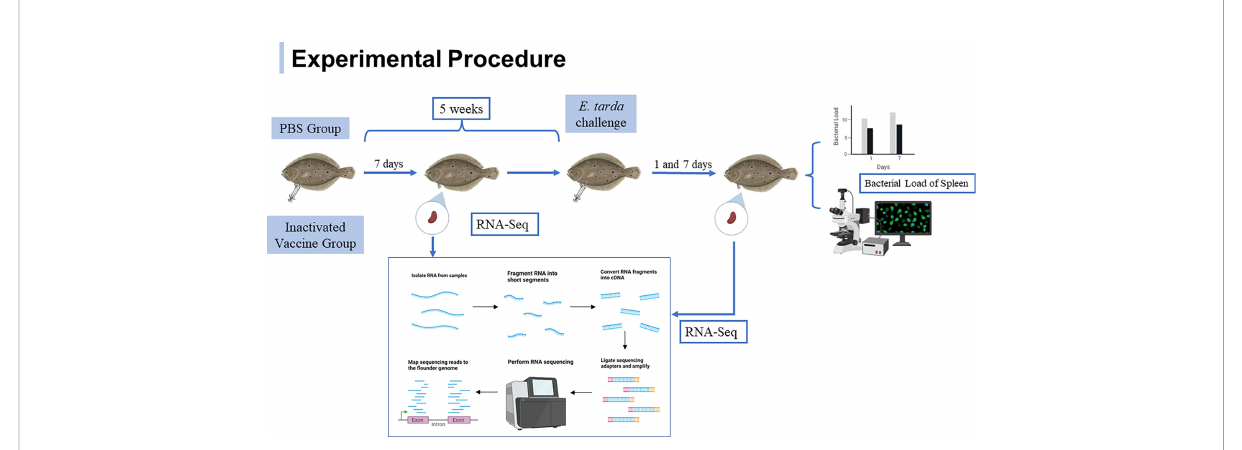
FIGURE 1 Experimental procedure of fl ounder after immunization with inactivated vaccine and subsequent E. tarda